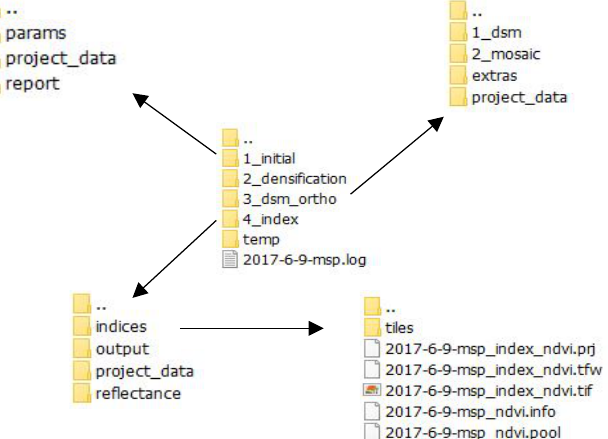
Figure 5. Project tree. When computing vegetation indices in pix4Dmapper, a folder of ‘indices’ is created where all outputs are stored. This is risky because all the data have the same name and, therefore, can be rewritten.